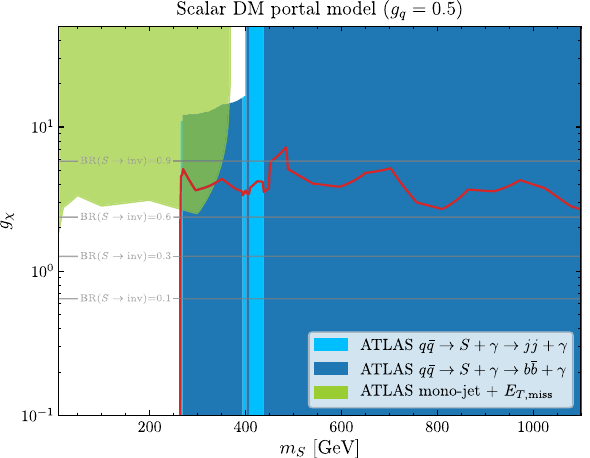
Fig. 4 Collider constraints on scalar dark matter portal model in the ( m , g χ ) parameterplanefor g = 0 . 5.Thebluecolouredareasindicate S q which di-jet search is expected to be most sensitive. The green colored area is excluded by the ATLAS mono-jet plus missing energy search of Ref. [63]. The area below the red curve is excluded by the ATLAS di-jet plus photon search [28]. The gray contours indicate the branching ratio of the scalar mediator S into invisible